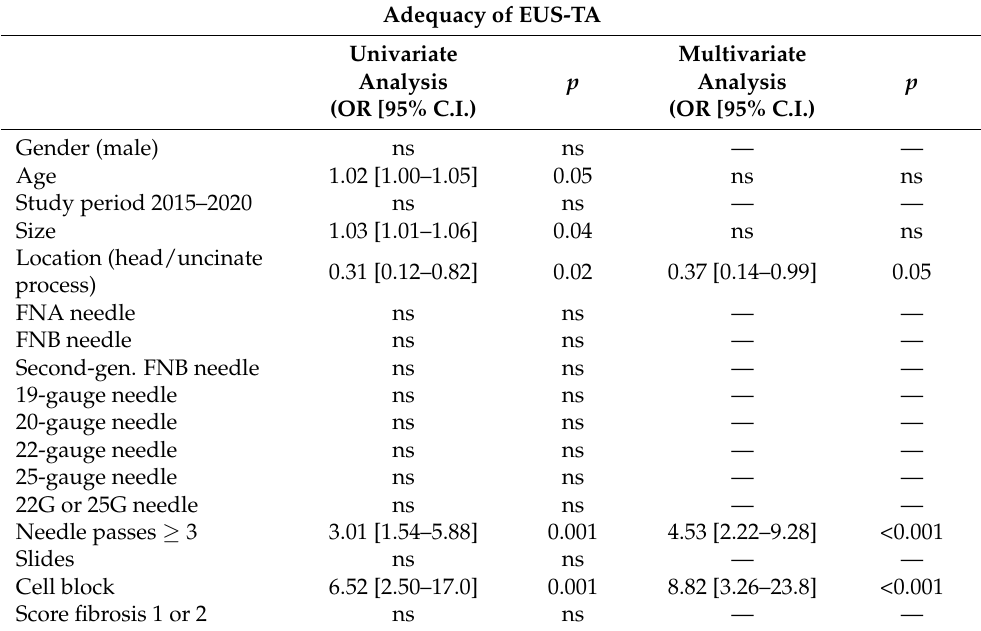
Table 3. Variables related to EUS-guided tissue acquisition specimen